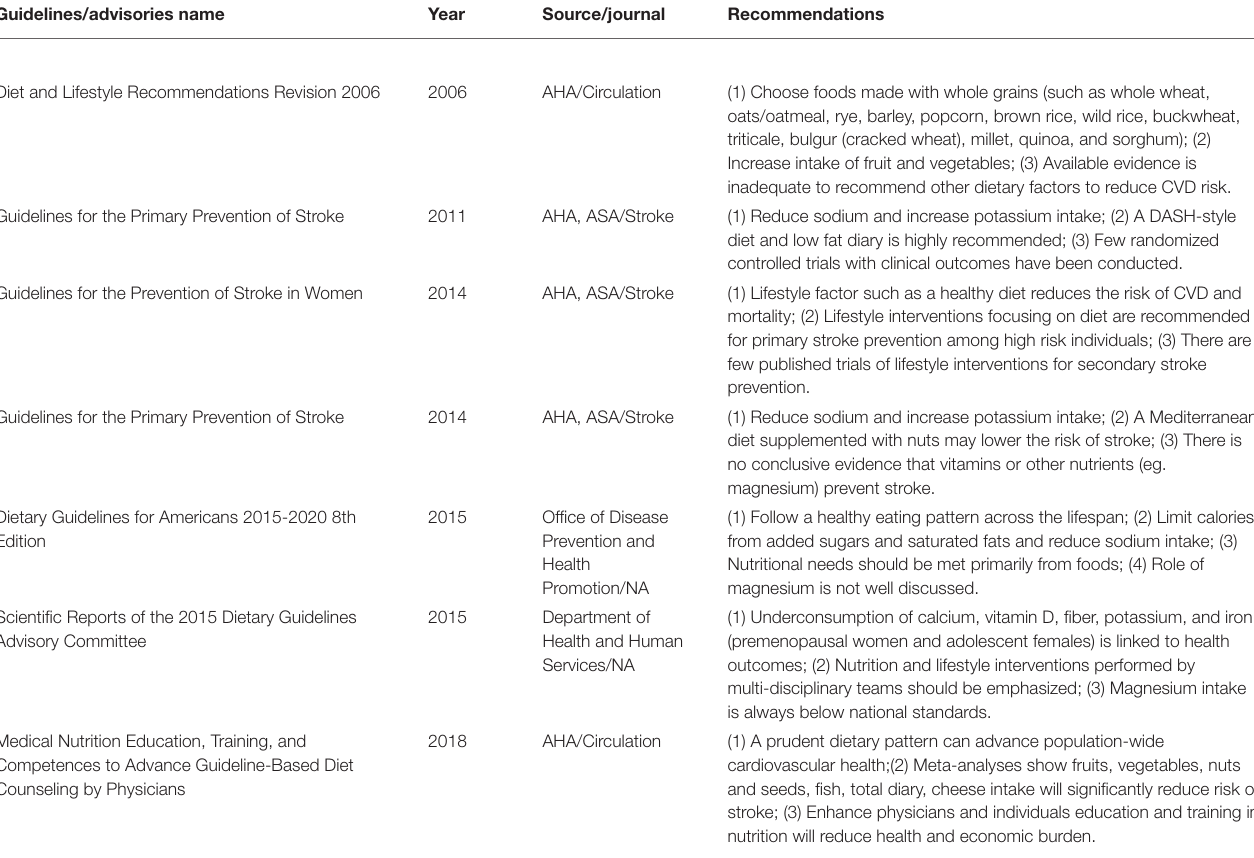
TABLE 2 | The summary of relevant guidelines or advisories by influential